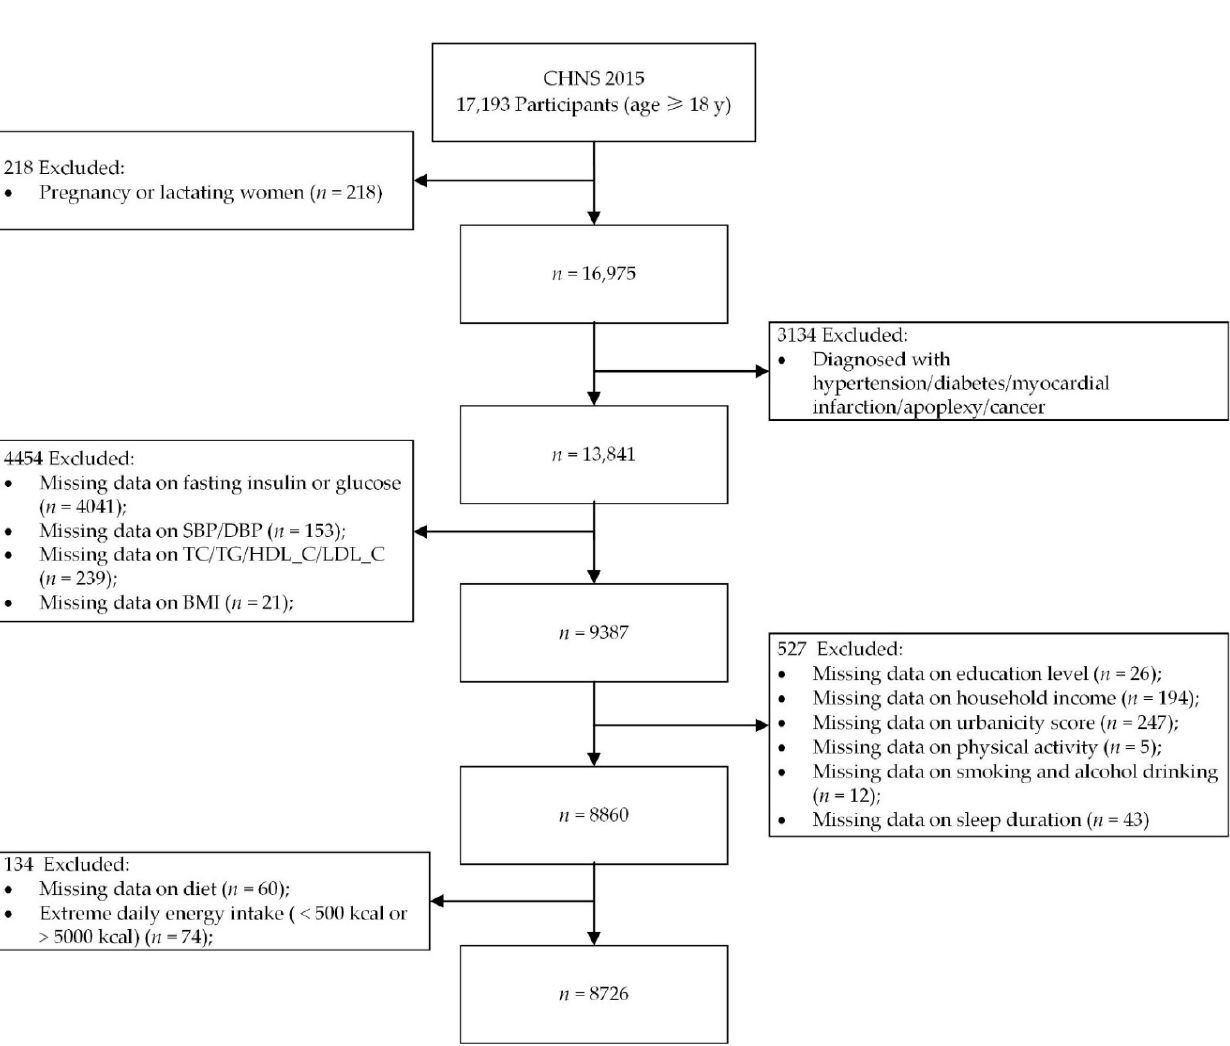
Figure 1. Flow chart of the included study population from the China Health and Nutrition Survey (CHNS) 2015. SBP, systolic blood pressure; DBP, diastolic blood pressure; TC, total cholesterol; TG, plasma total triglycerides; HDL_C, high-density lipoprotein cholesterol; LDL_C, low-density lipoprotein cholesterol; BMI, body mass index.